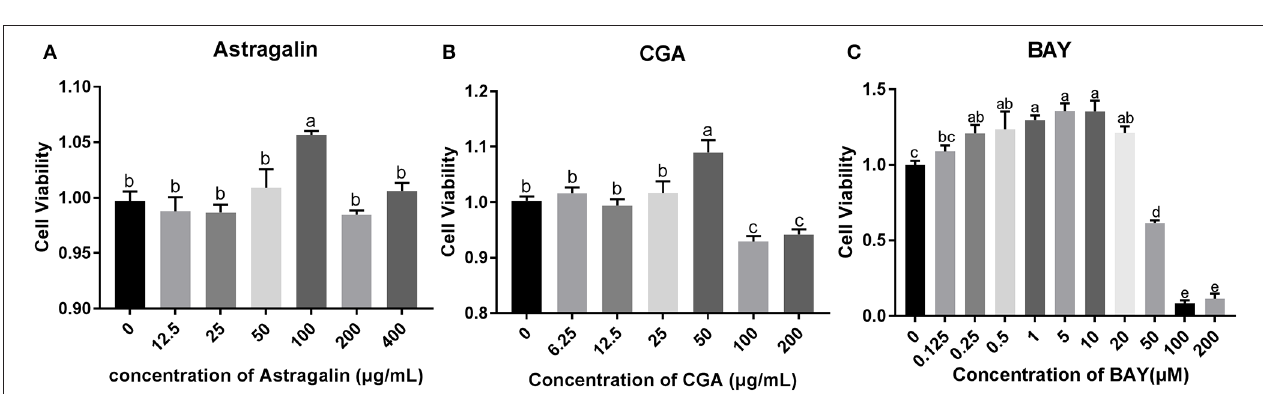
FIGURE 4 | The cell viability assay result of astragalin, CGA, and BAY. (A) The cell viability assay result of incubating with astragalin for 24h. (B) The cell viability assay result of incubating with CGA for 24h. (C) The cell viability assay result of incubating with BAY for 24h. Data are represented as the mean ± SD of three independent experiments with mixed SEECs from 15 sheep. Values with different lowercase letters were considered as statistically significant ( P < 0.05). The accurate P values of this article were listed in Supplementary Tables 1–4 .